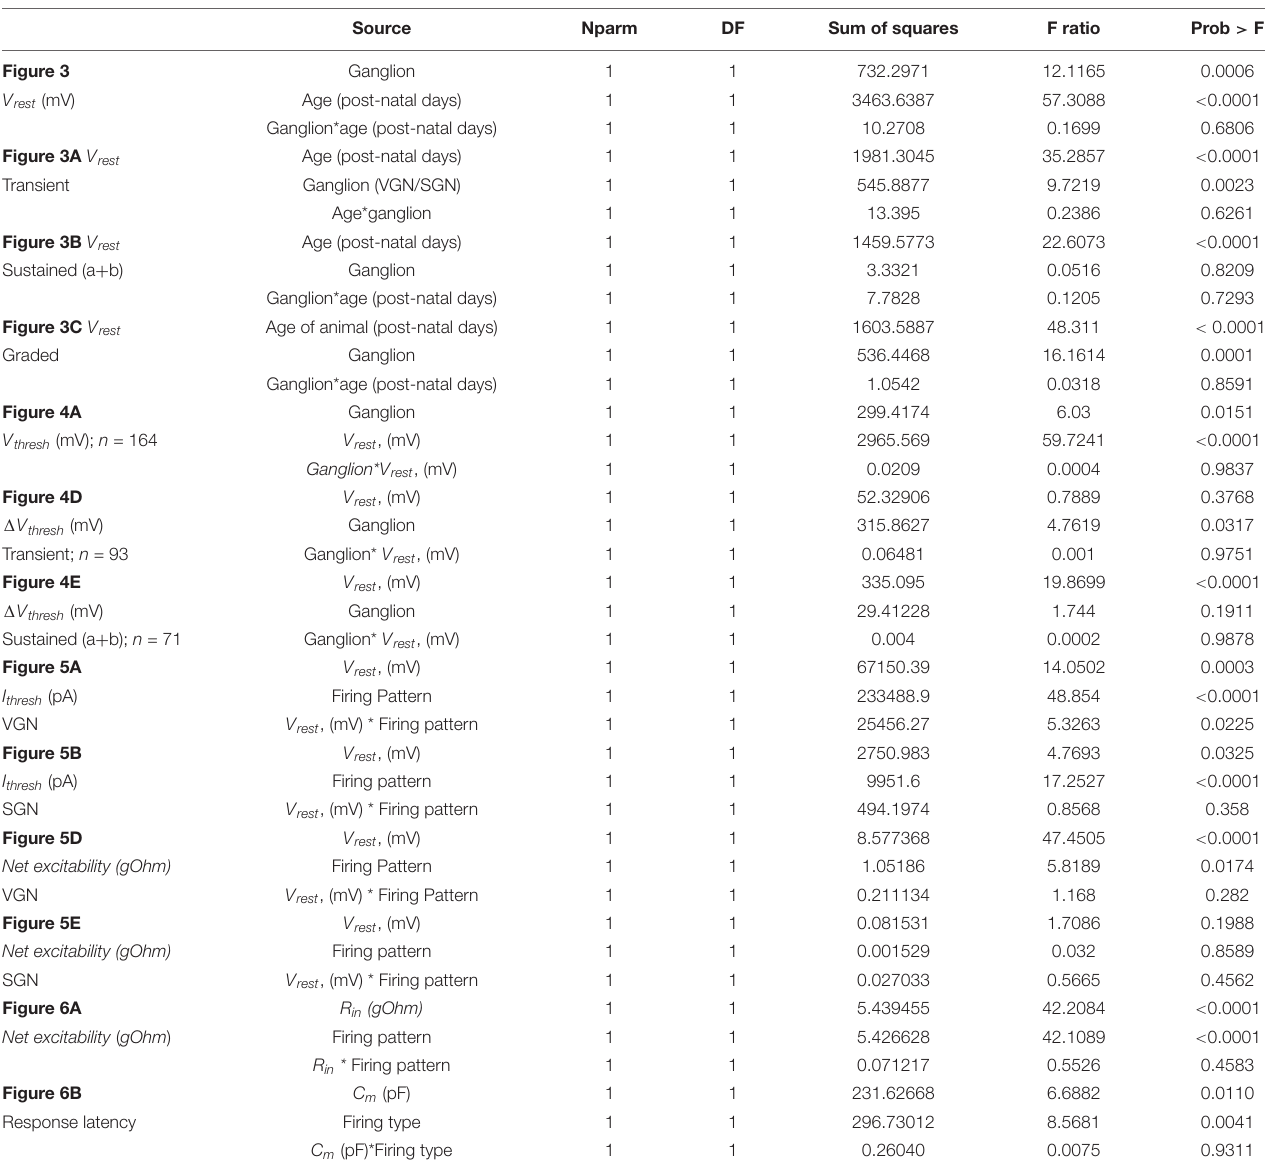
TABLE 1 | Analysis of covariance.